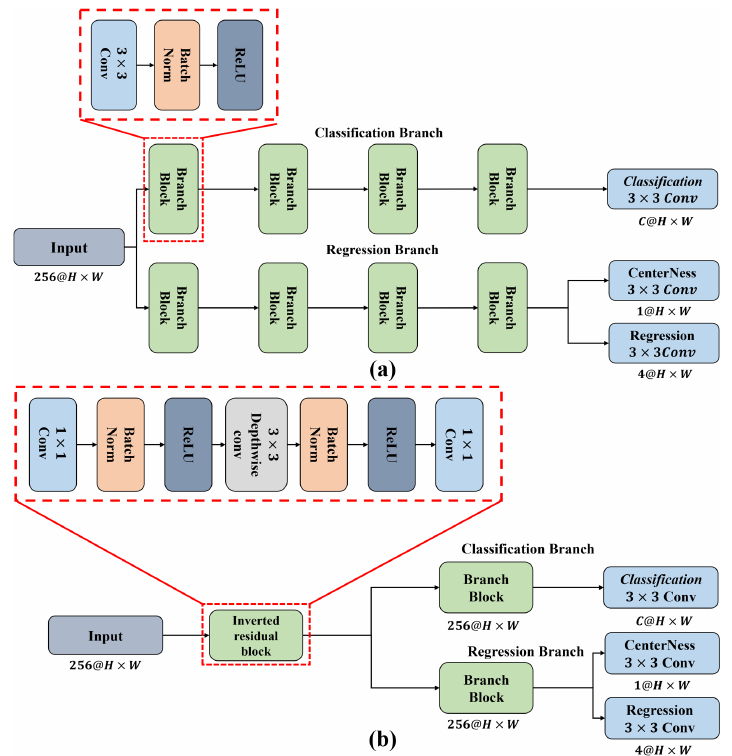
Figure 6. Detection head architecture: ( a ) Conventional decoupled head. It introduces repeated 3 × 3 convolutions to extract the feature for each task. ( b ) Proposed detection head. It used an inverted residual block, it was possible to extract features for each task with fewer operations and parameters shared than those of the conventional